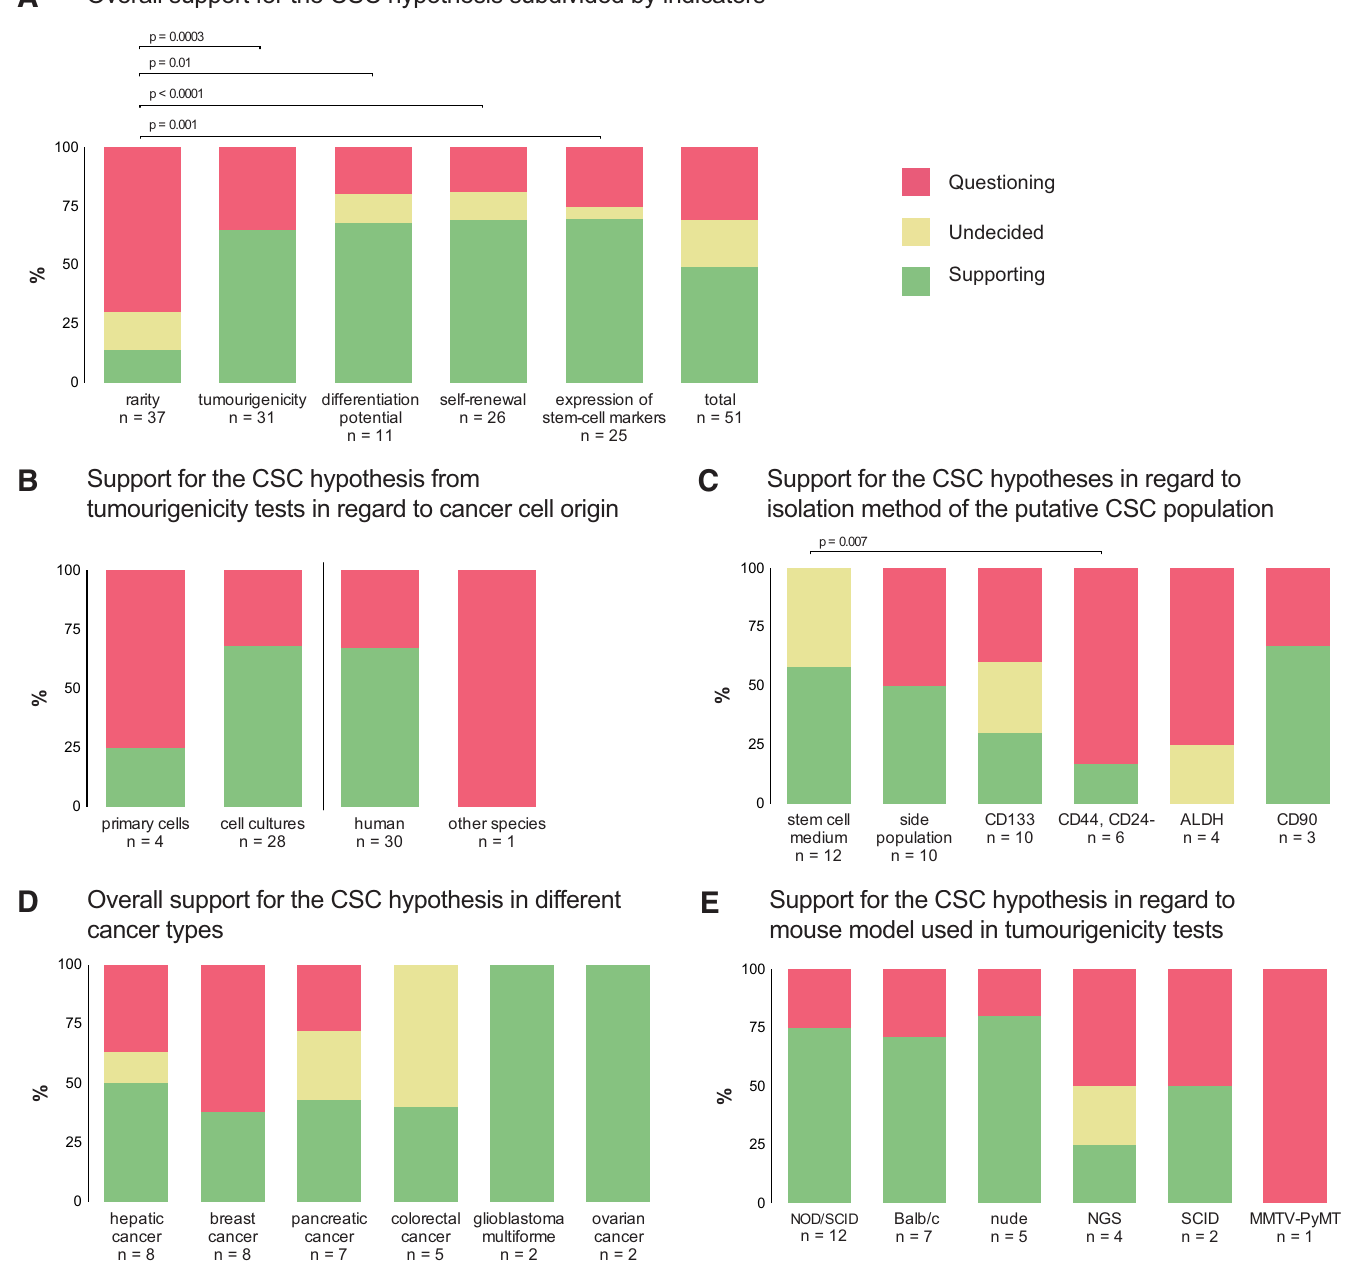
Fig 2. Empirical evidence regarding sub-hypotheses and further aspects of the Cancer Stem Cell hypothesis. The empirical evidence of each evaluated test was categorized as either supporting (S), being undecided (U) or questioning (Q), based on the data reported in the respective studies. N is the numbers of studies that tested the sub-hypotheses. Where the level of empirical support was significantly different (p < 0.05, Mann Whitney U-tests), the respective p-value is